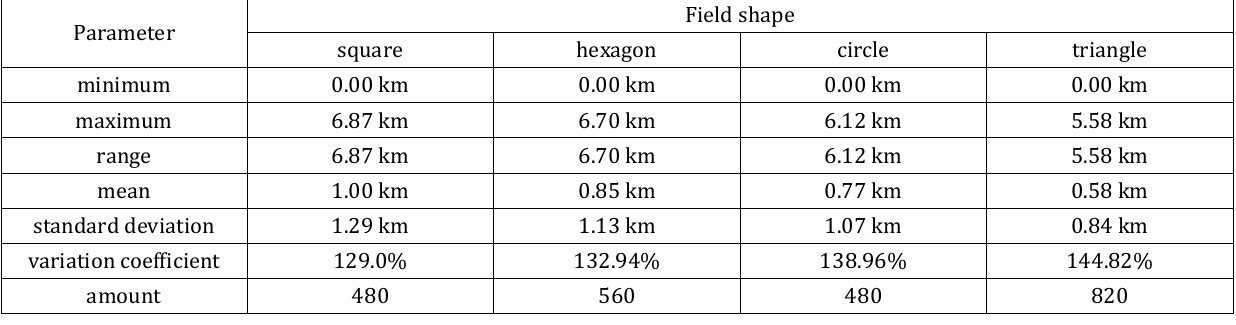
Table 4. Statistical data of basic fields (4 km)